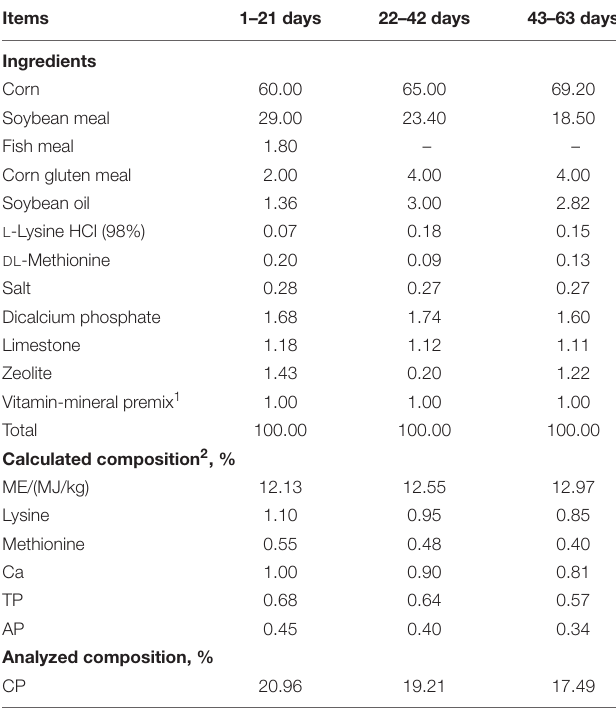
TABLE 1 | Feed ingredient and nutrient levels of experimental diets used in different phases of trial (%, as-fed basis).